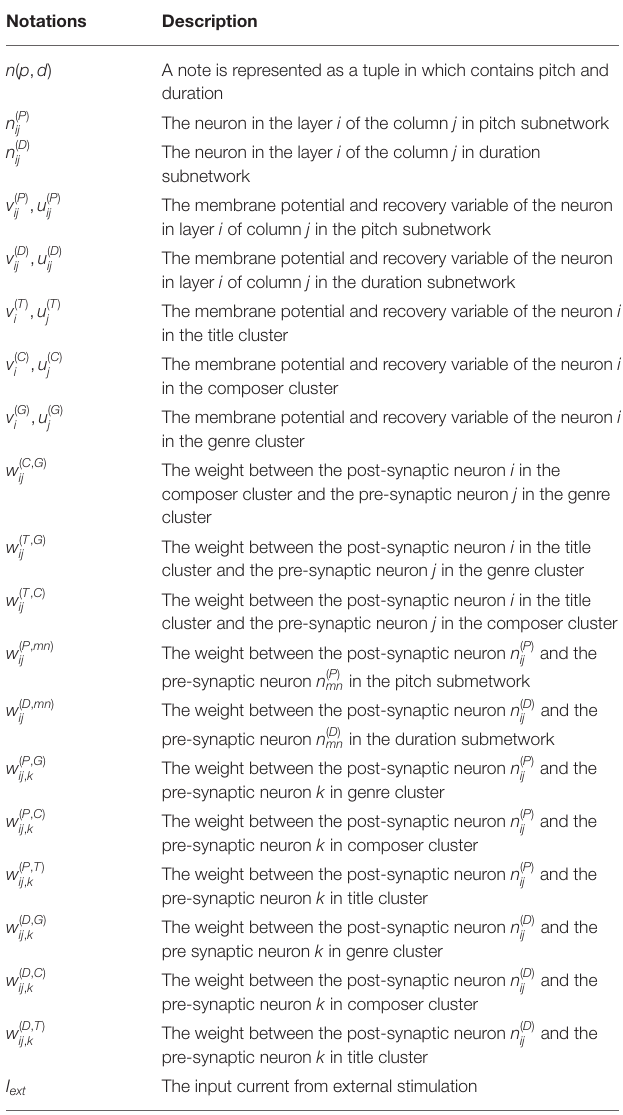
TABLE 1 | The important notation